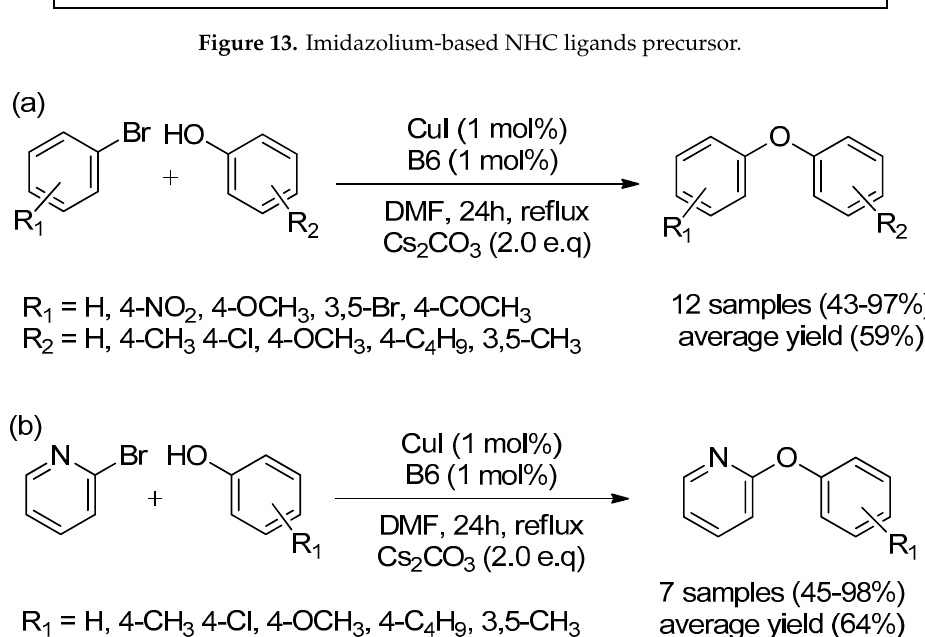
Scheme 45. ( a ) Formation of biaryl ethers in the presence of CuI salt and 1,3-bis-(2,6-diisopropylphenyl)- imidazolium chloride (IPrHCl) (B6) ligand; ( b ) heterocyclic biaryl